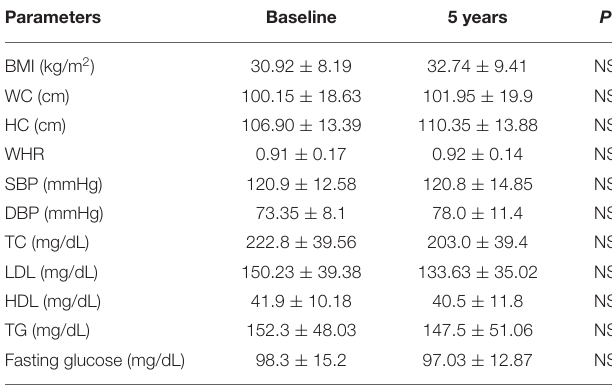
TABLE 3 | Clinical features of patients (group 1) at baseline and after 5-year follow-up.